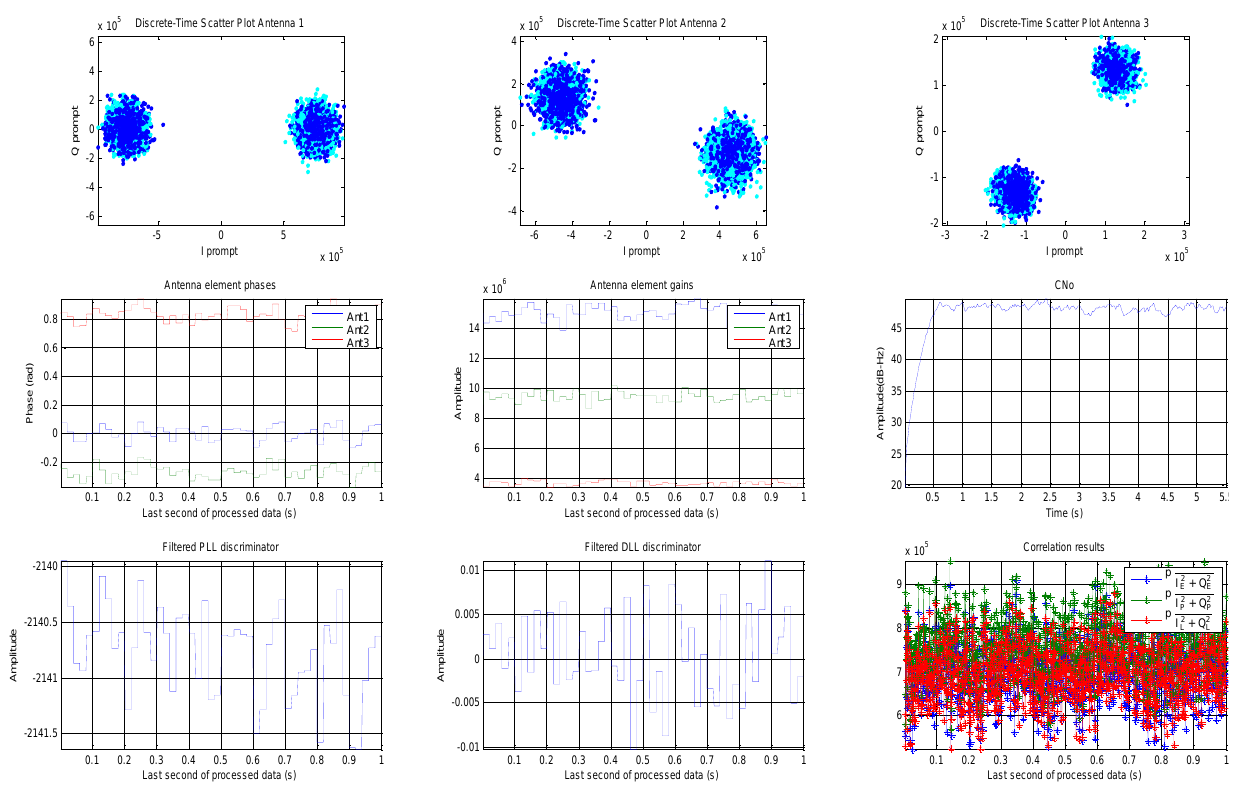
Figure 5. Tracking results of the multi-antenna receiver for one satellite signal.